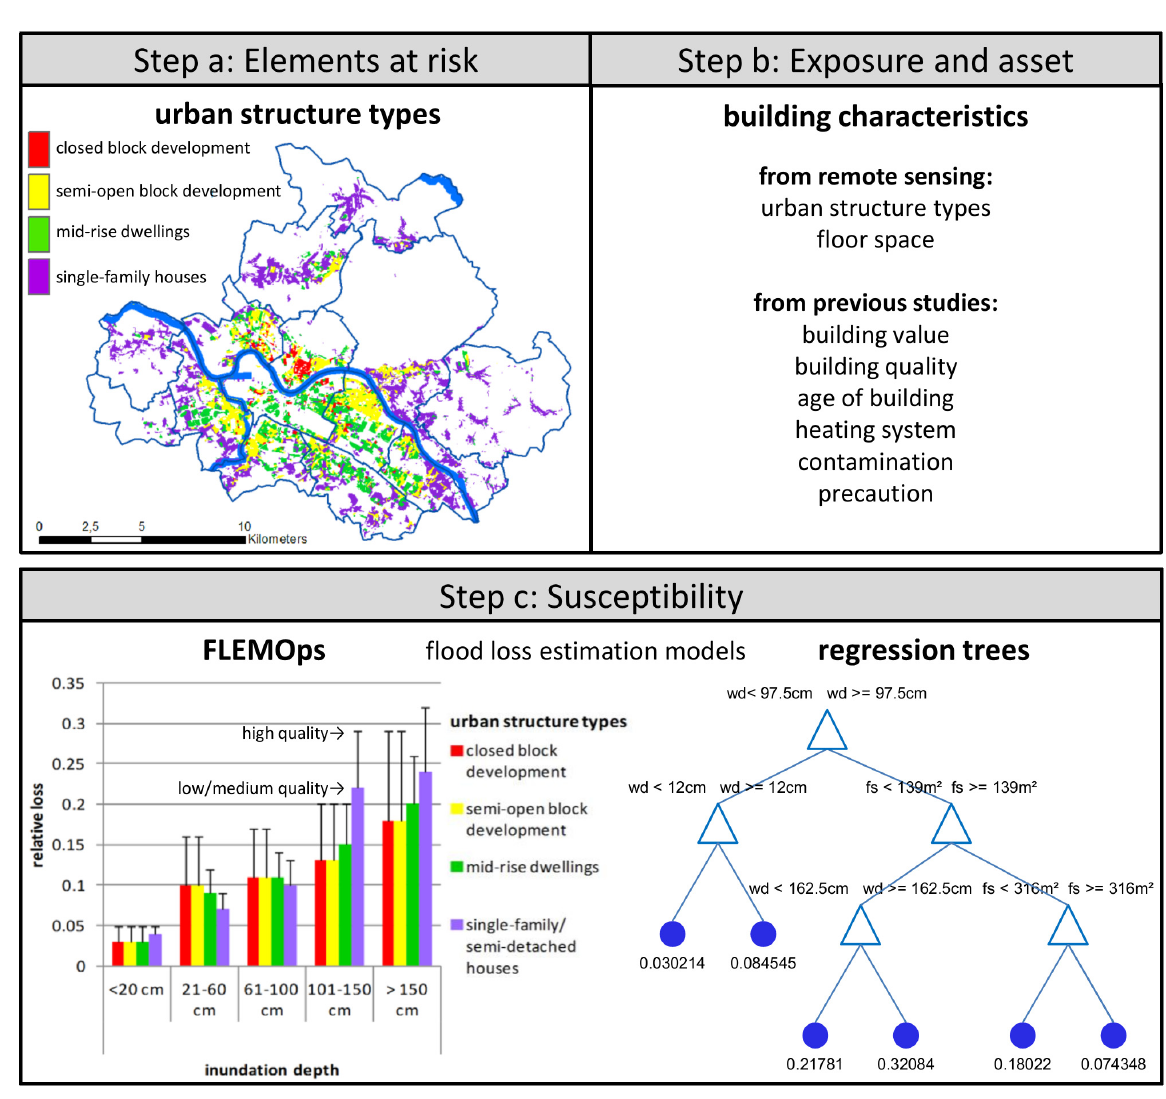
Figure 2. Three step procedure of flood loss assessment. Step ( a ) classification of elements at risk by pooling them into homogeneous classes; step ( b ) exposure analysis and asset assessment by describing the number and type of elements at risk and by estimating their asset value; and step ( c ) susceptibility analysis using FLEMOps and regression tree models. Input data that are used in the three processing steps are listed in Table